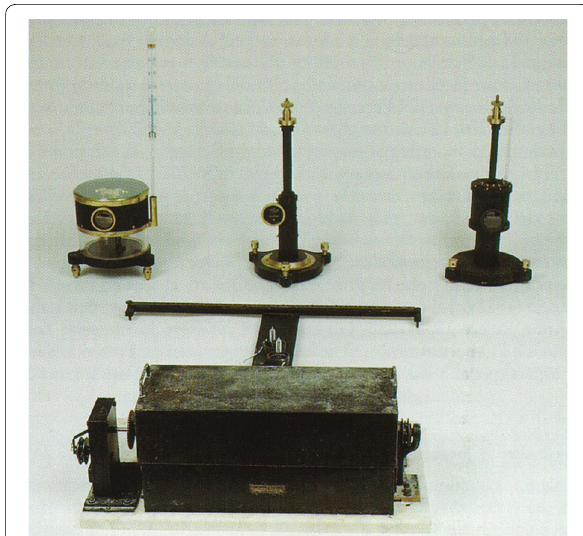
Fig. 11 LaCour magnetograph: in the background, the Z (left), D (center) and H (right) sensors, and in the foreground, the case with the photographic drum for making the recording. Notice the clockwork motor on the left-hand side